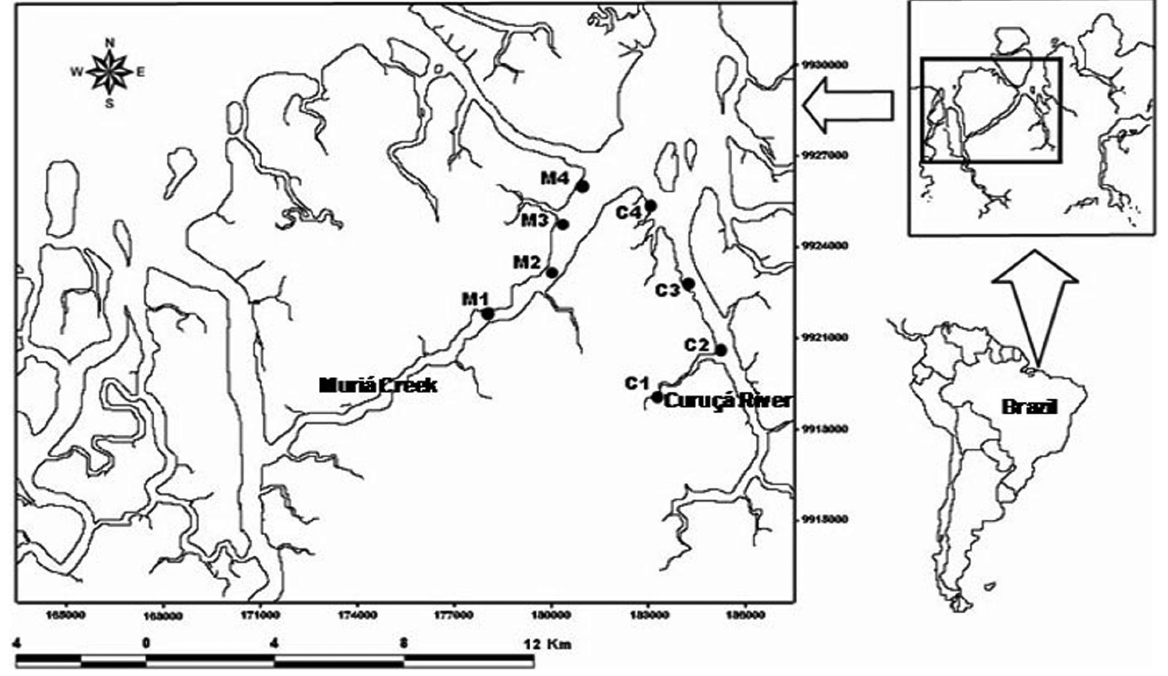
Fig. 1 – Map of Curuçá County (Amazon Region) showing the sampling stations in the Muriá Creek (M1 to M4) and Curuçá River (C1 to C4). metric methodology adapted from Strickland and Par- sons